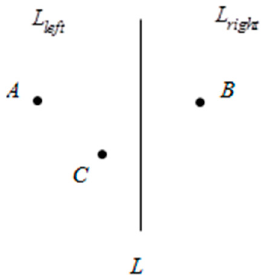
Figure 3. Theorem description graph. Figure 6. Theorem description graph.